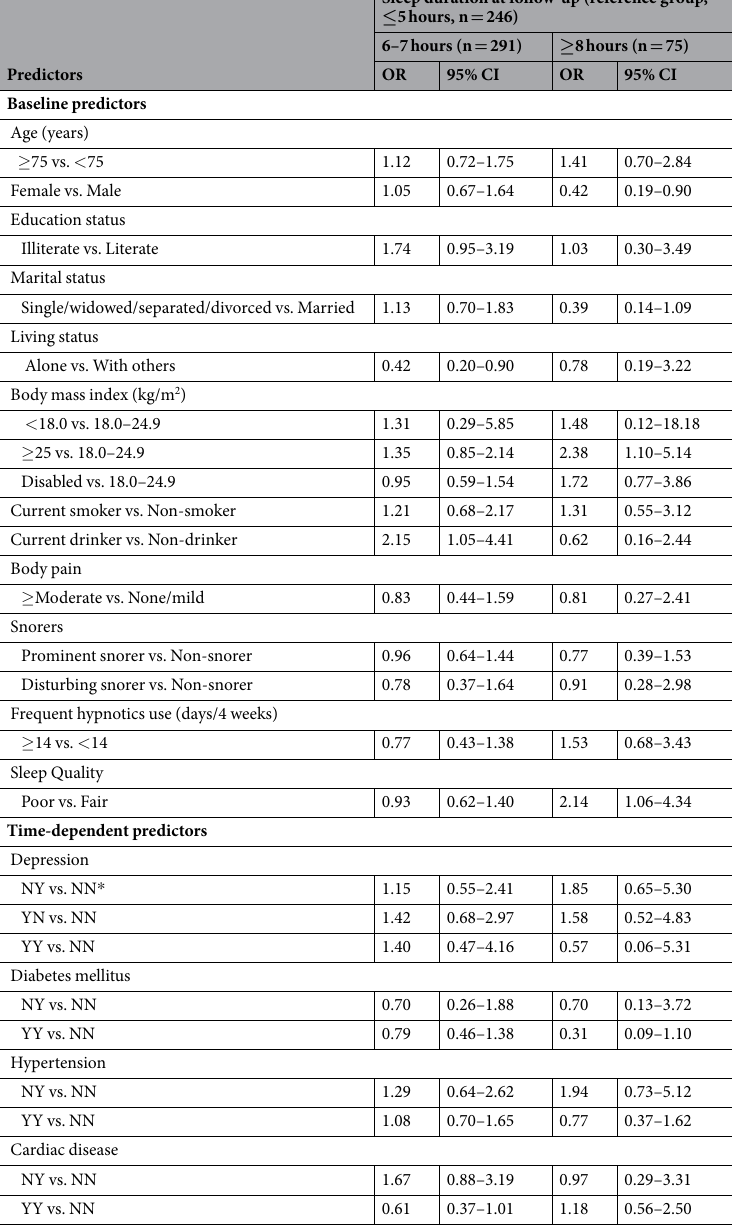
Table 3. Multinomial logistic regression for factors predicting change of sleep duration among short sleepers at baseline (n = 612). * NN: absent for both baseline and follow-up survey; NY: incident condition during the follow-up period; YN: present in the baseline but remitted during follow-up; YY: present in the